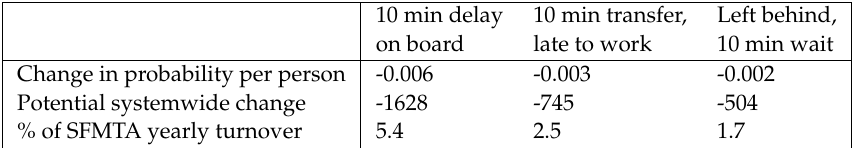
Table 4. Results of the